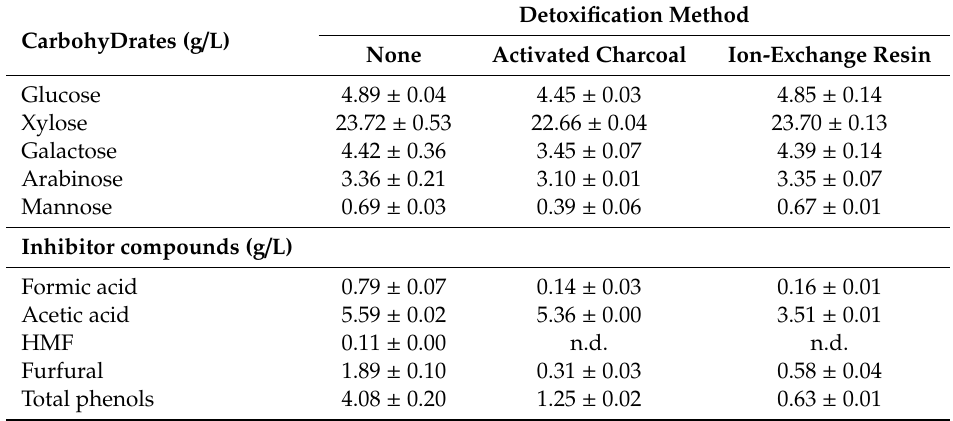
Table 1. Sugar and inhibitor compound concentrations in acid hydrolysate before and after detoxification. Detoxification Method CarbohyDrates (g / L) None Activated